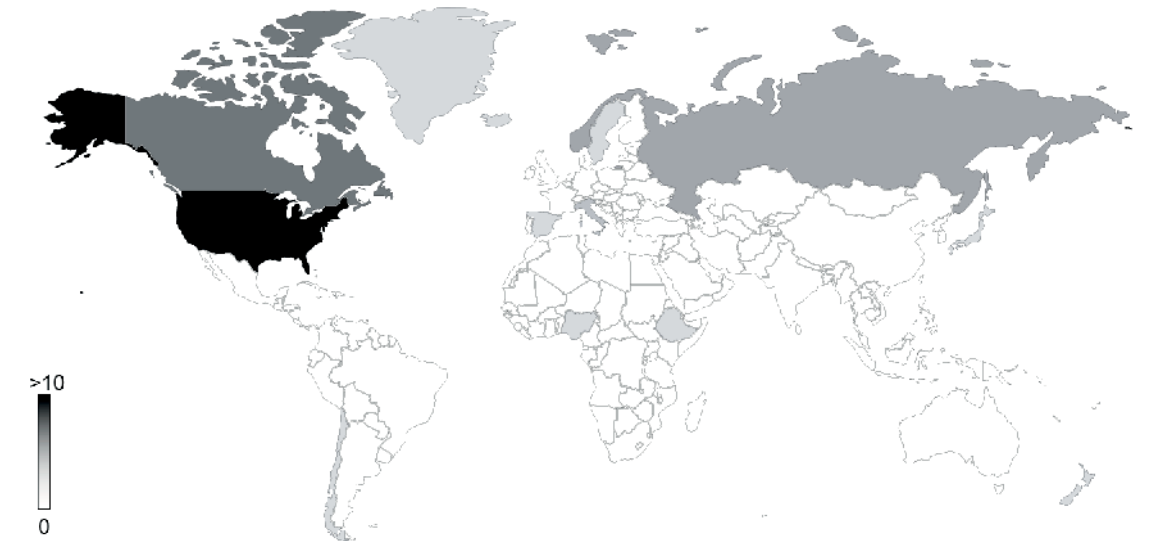
Figure 2. World heat map of virus detected in extreme environments. Locations are colored (gray scale) according to the amount of reviewed literature originating from specific country. Locations are shown by country and represented with a grey scale.